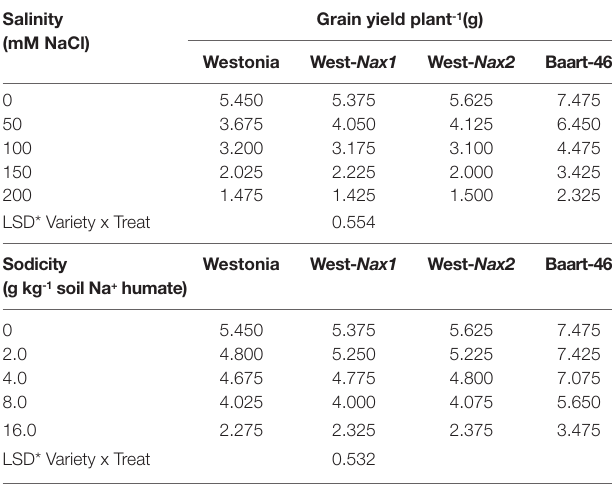
TABLE 1 | Best linear unbiased estimates for grain yield in bread wheat Triticum aestivum L .) cv. Westonia, Westonia- Nax1 , Westonia- Nax2 , and Baart- 46 under different levels of salinity and sodicity in Experiment 2 (n = 4).